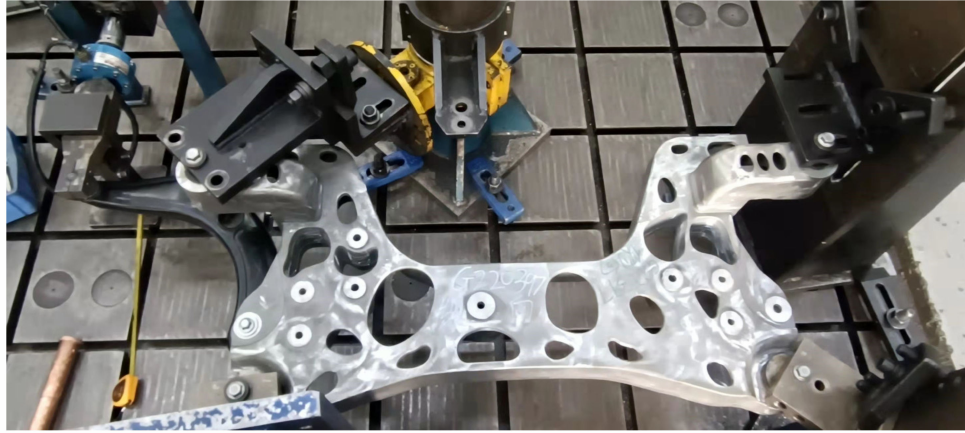
Figure 26. Longitudinal fatigue endurance test of aluminium alloy front subframe on